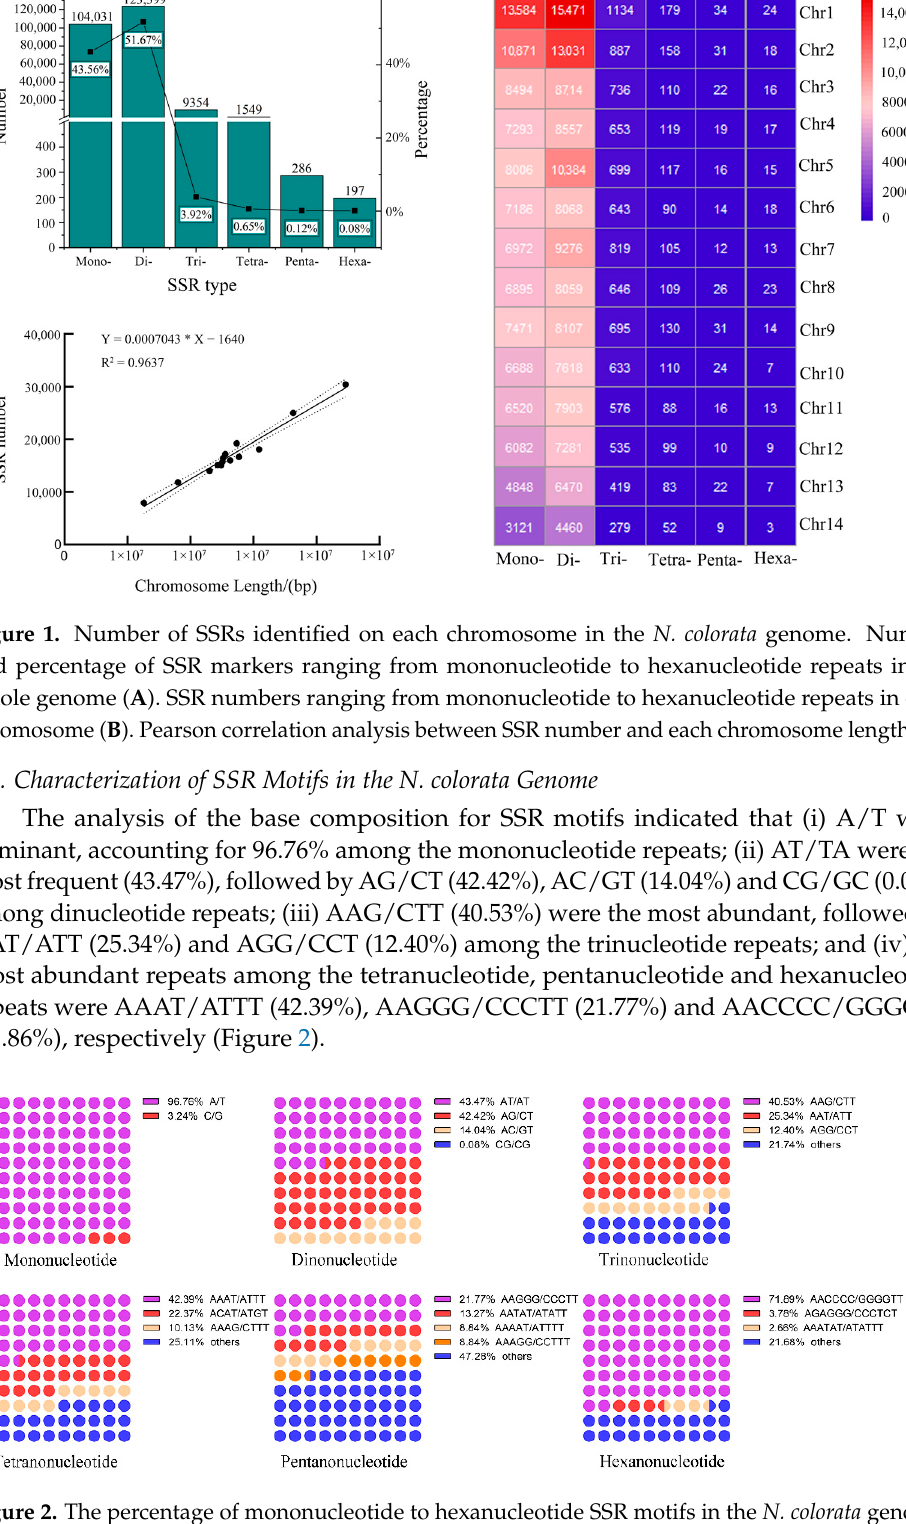
Figure 2. The percentage of mononucleotide to hexanucleotide SSR motifs in the N. colorata genome.